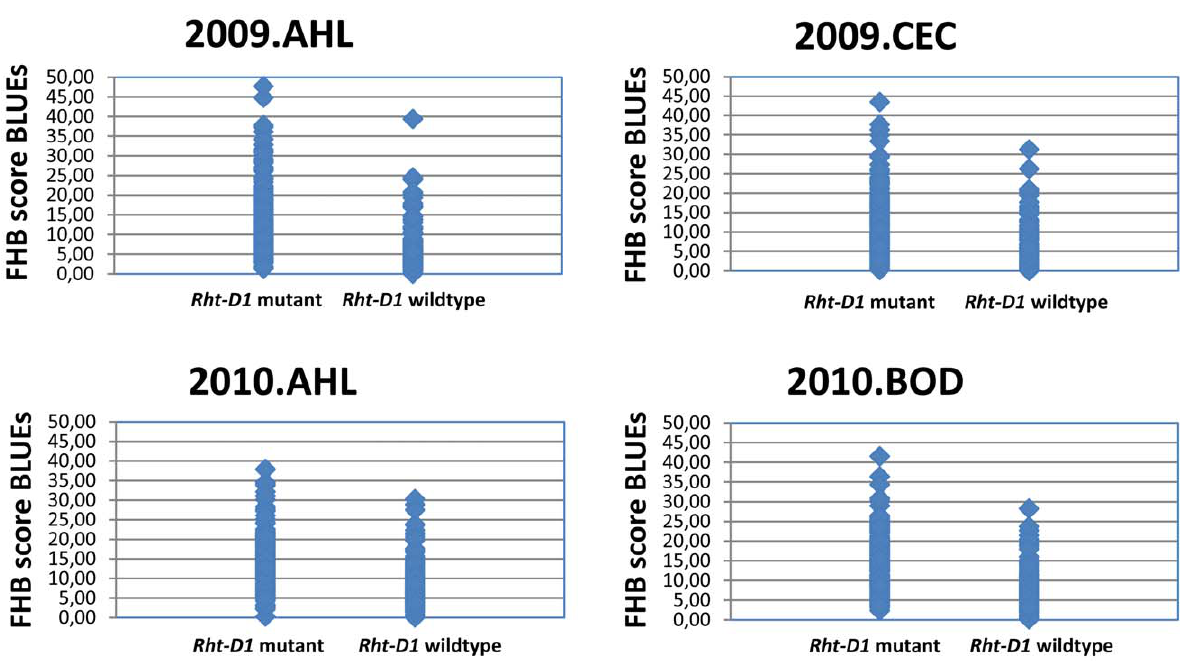
Figure 5. Allelic effects of dwarfing gene Rht-D1 in a population of 372 European wheat varieties. Varieties carrying the mutant allele Rht-D1b (dwarfing type) showed an increased FHB score resulting in decreased resistance in four different environments.